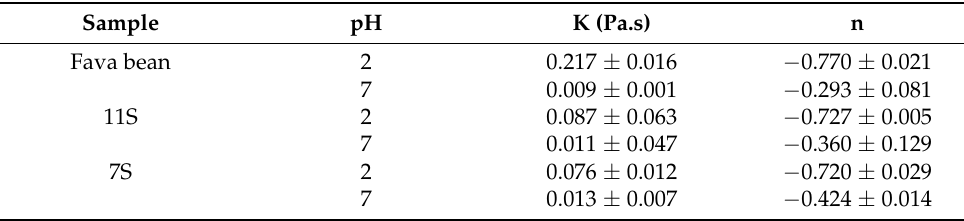
Table 1. The flow consistency index (K) and flow behaviour index (n) for fibrillated protein from fava bean, 11S, and 7S at pH 2 and pH